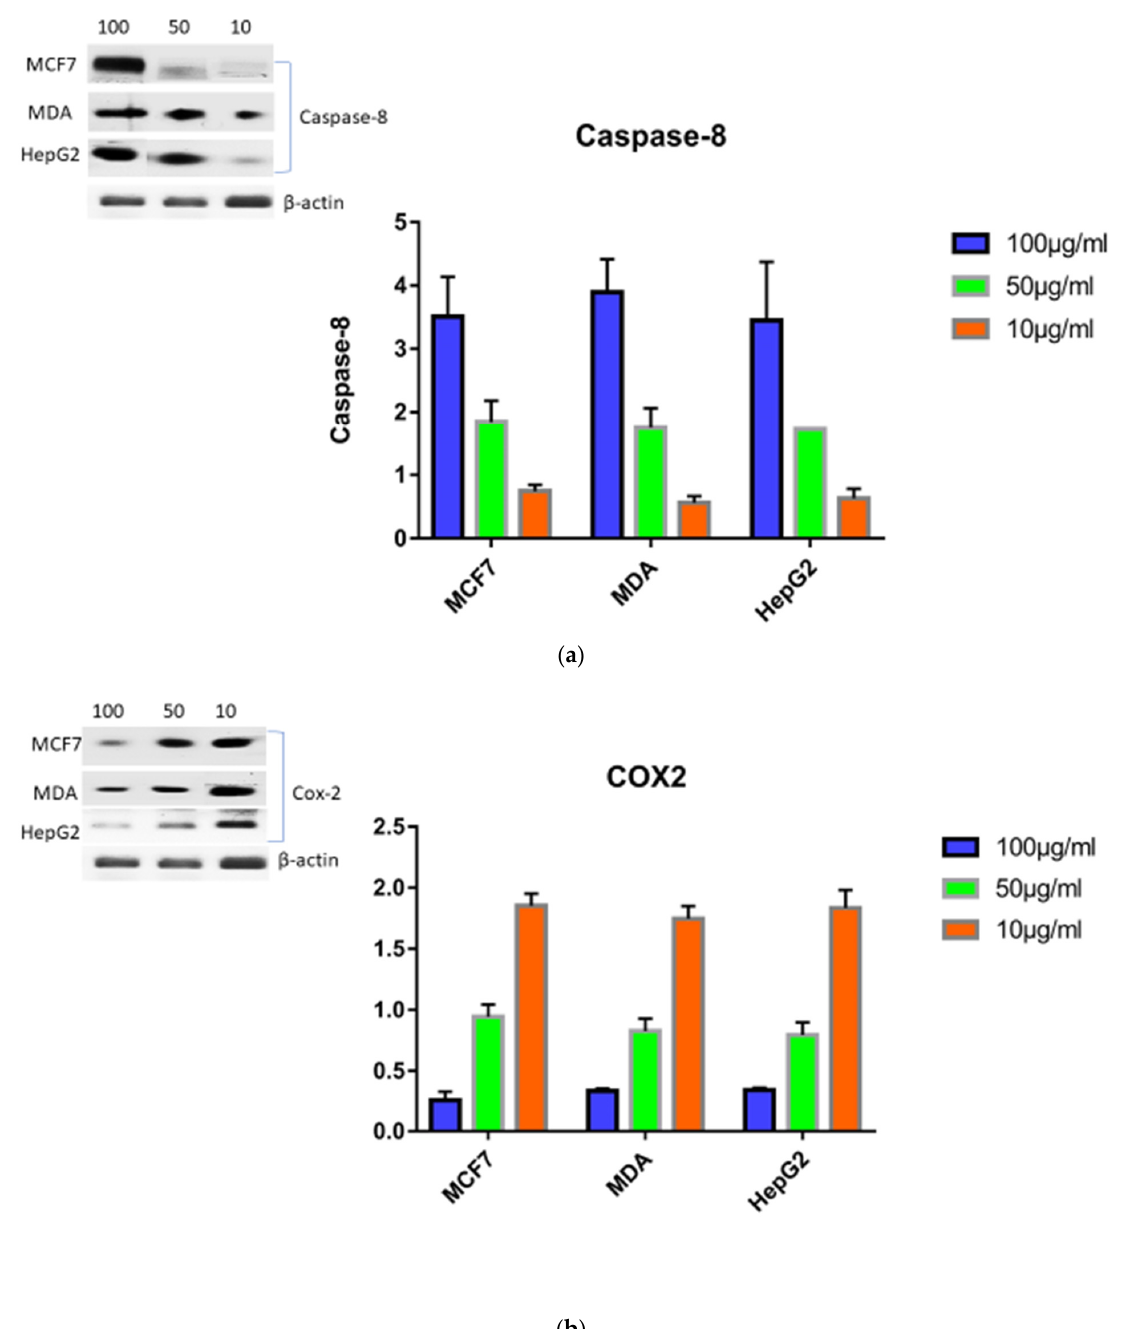
Figure 7. ( a ) Effect of Er-ZnONPs on caspase-8. ( b ) Effect of Er-ZnONPs on COX-2